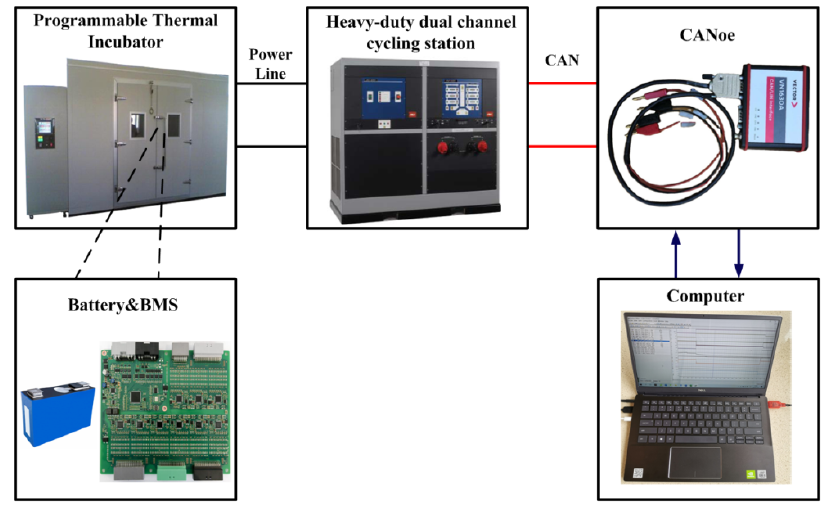
Figure 6. Block diagram of battery system test bench.